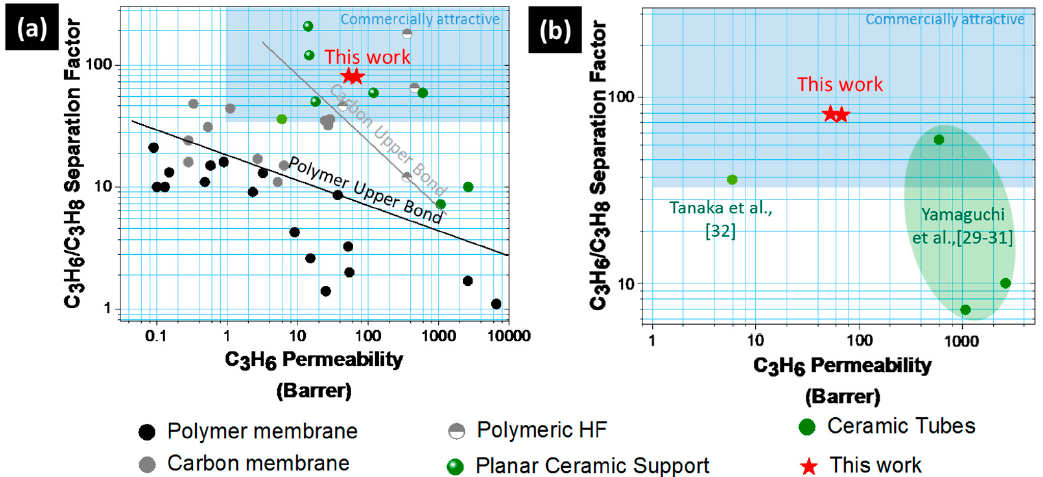
Figure 5. Propylene/propane separation performance of our ZIF-8 tubular ZIF-8 membranes in comparison with ( a ) all other membranes and ( b ) other ZIF-8 membranes supported on ceramic tubes. HF stands for hollow fiber.